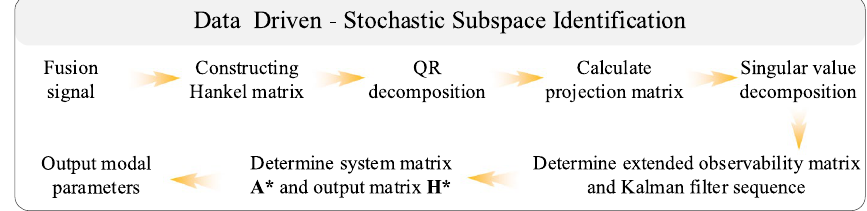
Fig. 2 The working principle of data-driven SSI